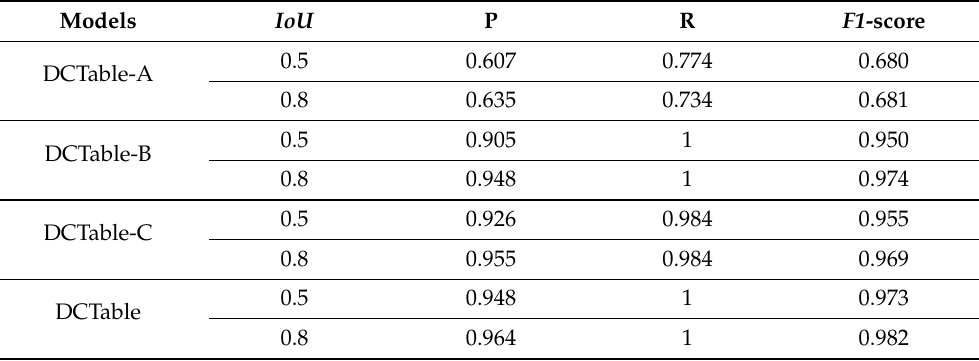
Table 4. Evaluation on